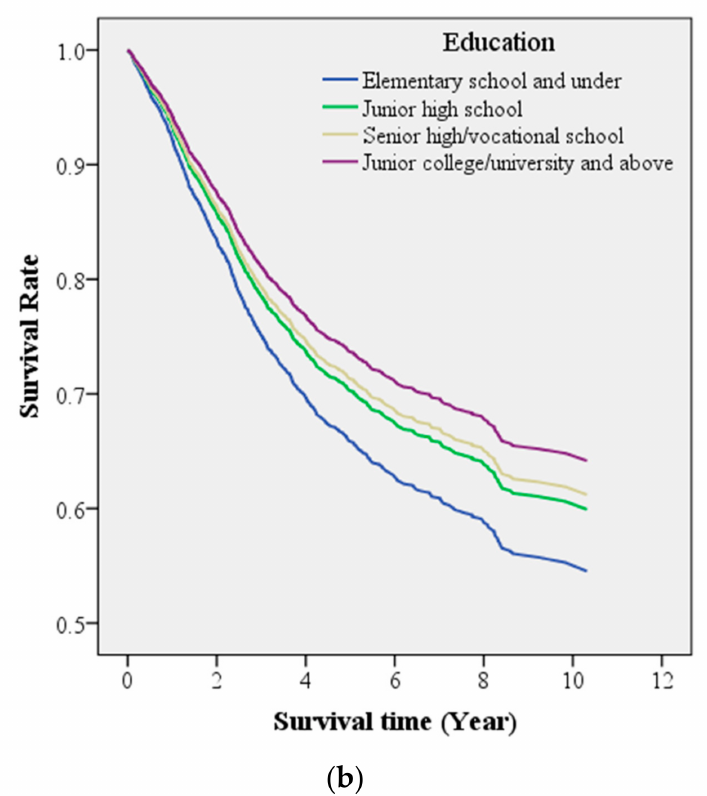
Figure 2. ( a ) The survival curves of colorectal cancer patients with varying monthly salaries. ( b ) The survival curves of colorectal cancer patients with varying education